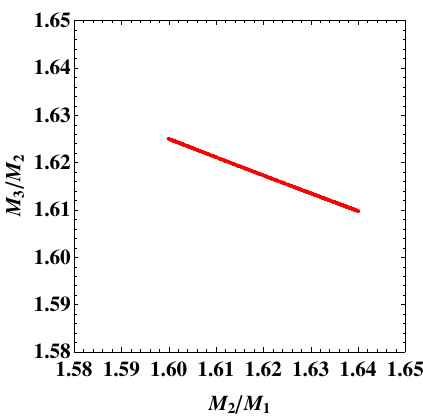
Figure 1 . The allowed region of mass ratios between right-handed neutrinos.